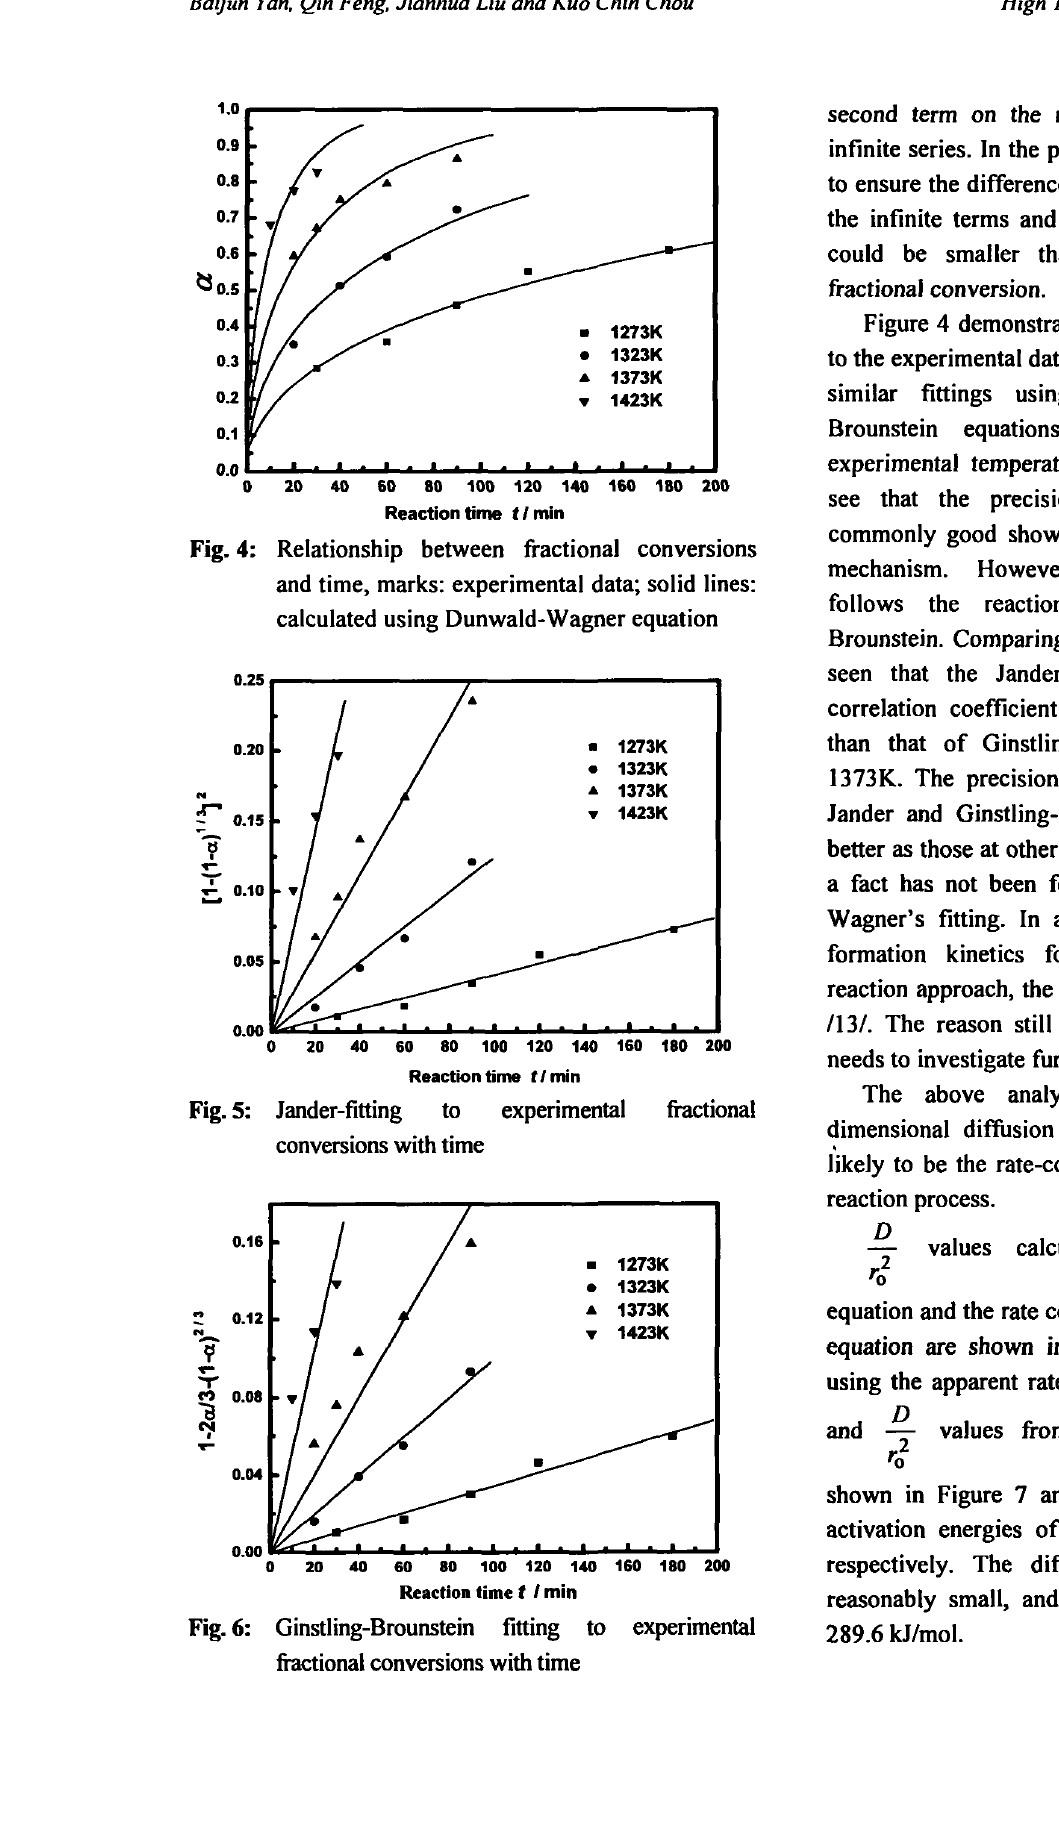
Fig. 6: Ginstling-Brounstein fitting to experimental fractional conversions with